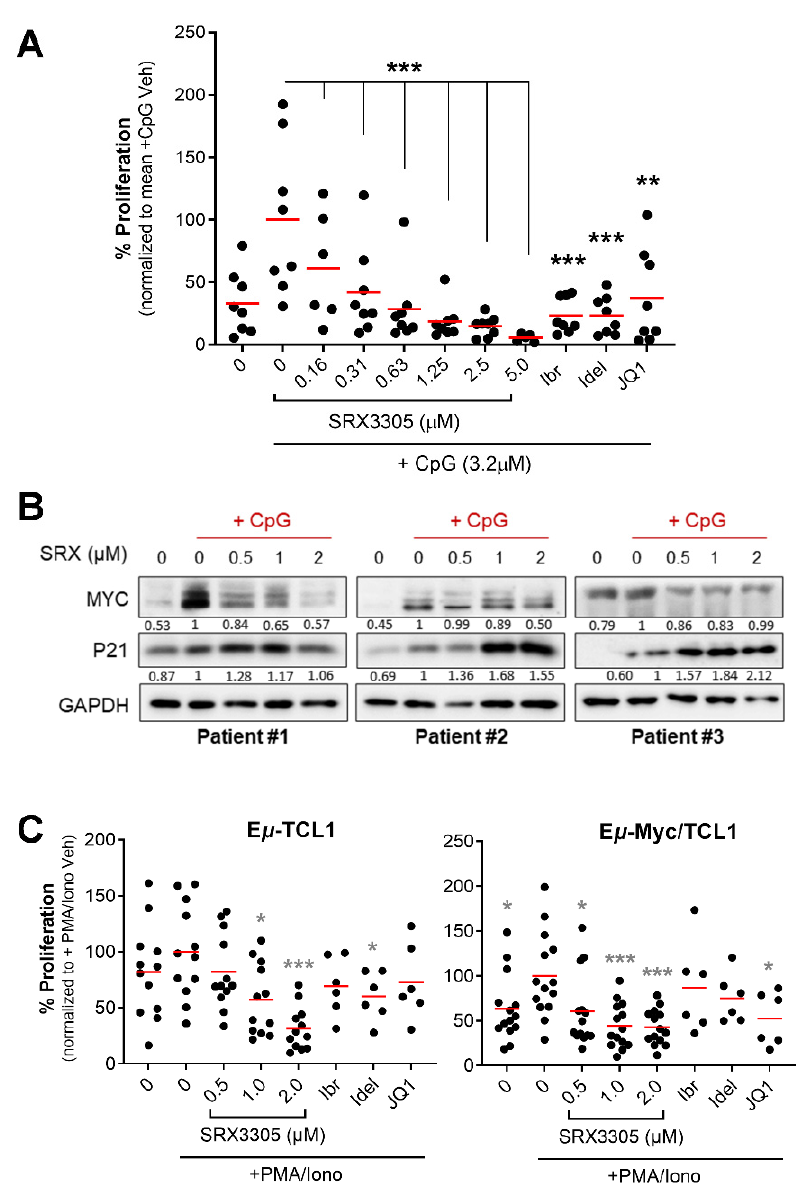
Figure 3. Antitumor effects of SRX3305 in primary CLL samples. ( A ) Patient-derived CLL cells ( n = 8) were treated with the indicated concentrations of SRX3305; 1 µM of ibrutinib (Ibr), idelalisib (Idel), or JQ1; or DMSO vehicle. They were then stimulated with CpG oligodeoxynucleotides (+CpG; 3.2 µM) for 48 h. Proliferation was assessed via MTS assay, and results are given as % proliferation normalized to mean stimulated vehicle (+CpG Veh). Red lines indicate average values. p values indicate significance vs. stimulated vehicle. ( B ) Patient-derived CLL cells ( n = 6) were treated with DMSO vehicle or the indicated SRX3305 concentrations for 4 h in the presence of CpG oligonucleo- tides (+CpG, 3.2 µM). The protein expression of MYC and P21 was determined by immunoblot anal- ysis. GAPDH serves as a loading control. Representative immunoblots from three patients are shown. Numbers below the bands represent densitometric quantification relative to loading control and normalized to +CpG Veh. ( C ) Lymphocytes isolated from spleens of terminally diseased E μ - TCL1 ( n = 6–12) or E μ -Myc/TCL1 ( n = 6–14) mice were stimulated with 1X PMA/Ionomycin (+PMA/Iono) and treated with DMSO vehicle or increasing concentrations of SRX3305 as indicated, or 1 µM Ibr, Idel, or JQ1. Proliferation was assessed via MTS assay 48 h later, and results are given as % proliferation normalized to mean stimulated vehicle (+PMA/Iono Veh). Red lines indicate av- erages. P values indicate significance vs. stimulated vehicle. * p < 0.05, ** p < 0.01, *** p < 0.001. We next investigated SRX3305-induced cytotoxicity on tumor cells derived from mu- rine models of aggressive B-cell leukemia and lymphoma. We utilized malignant B-cells